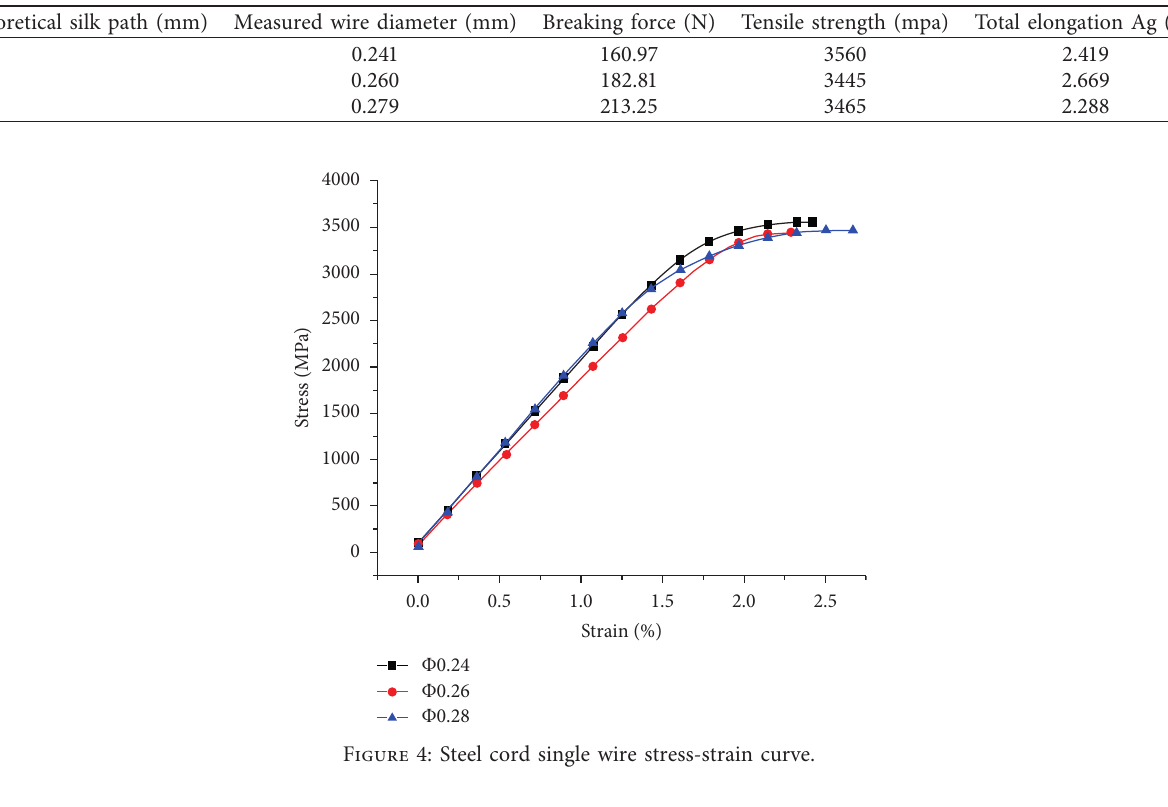
Table 2: Single-wire stretch performance.